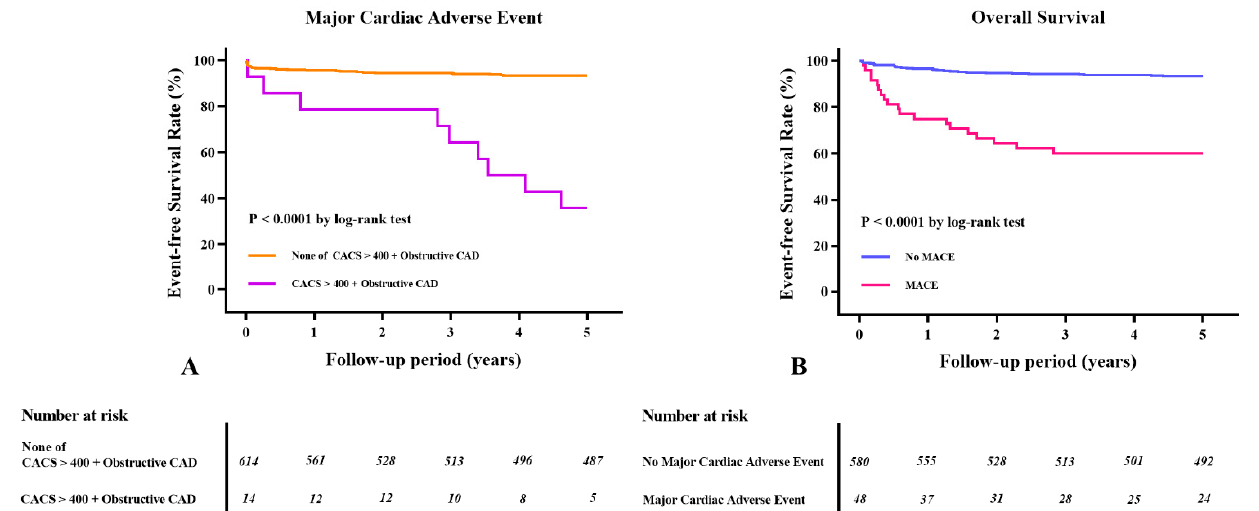
Figure 2. Kaplan–Meier curves. ( A ) Major adverse cardiac event (MACEs) according to the coronary artery calcium score (CACS) of >400 combined with obstructive coronary artery disease (CAD). ( B ) Overall survival according to the MACEs that developed.